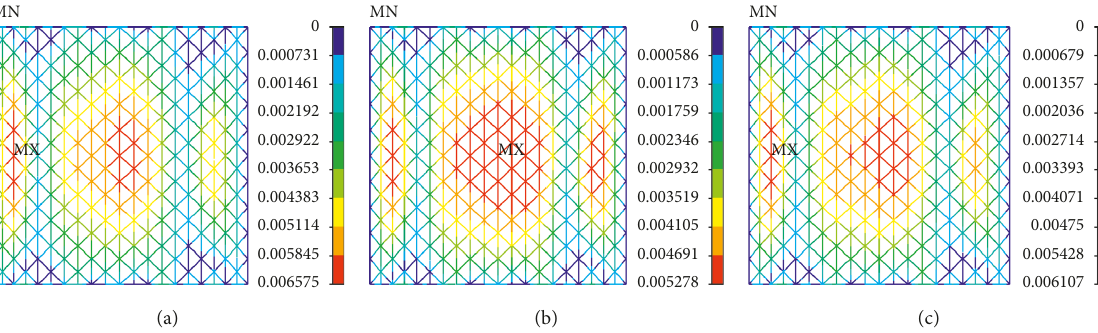
Figure 17: The response displacement distributions on single-layer reticulated cylindrical shells with optimal and near optimal rise-to-span ratios. (a) R / S � 1/7. (b) R / S � 1/5.5. (c) R / S �